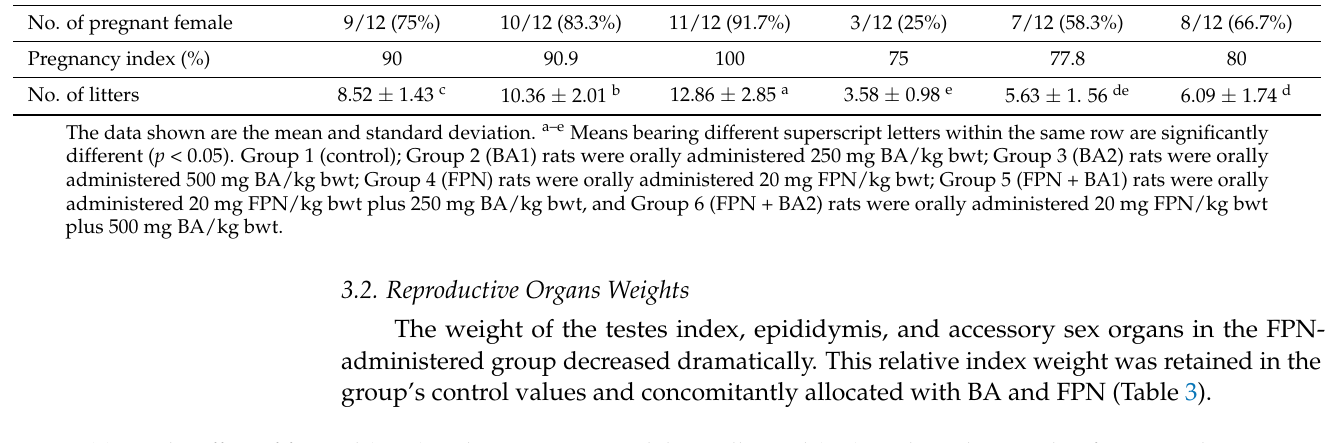
Table 3. The effect of fipronil (FPN) and co-treatment with boswellic acid (BA) on the index weight of rat reproductive